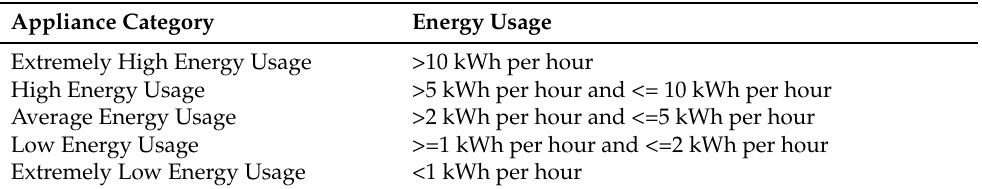
Table 6. Categorization of different appliances according to energy